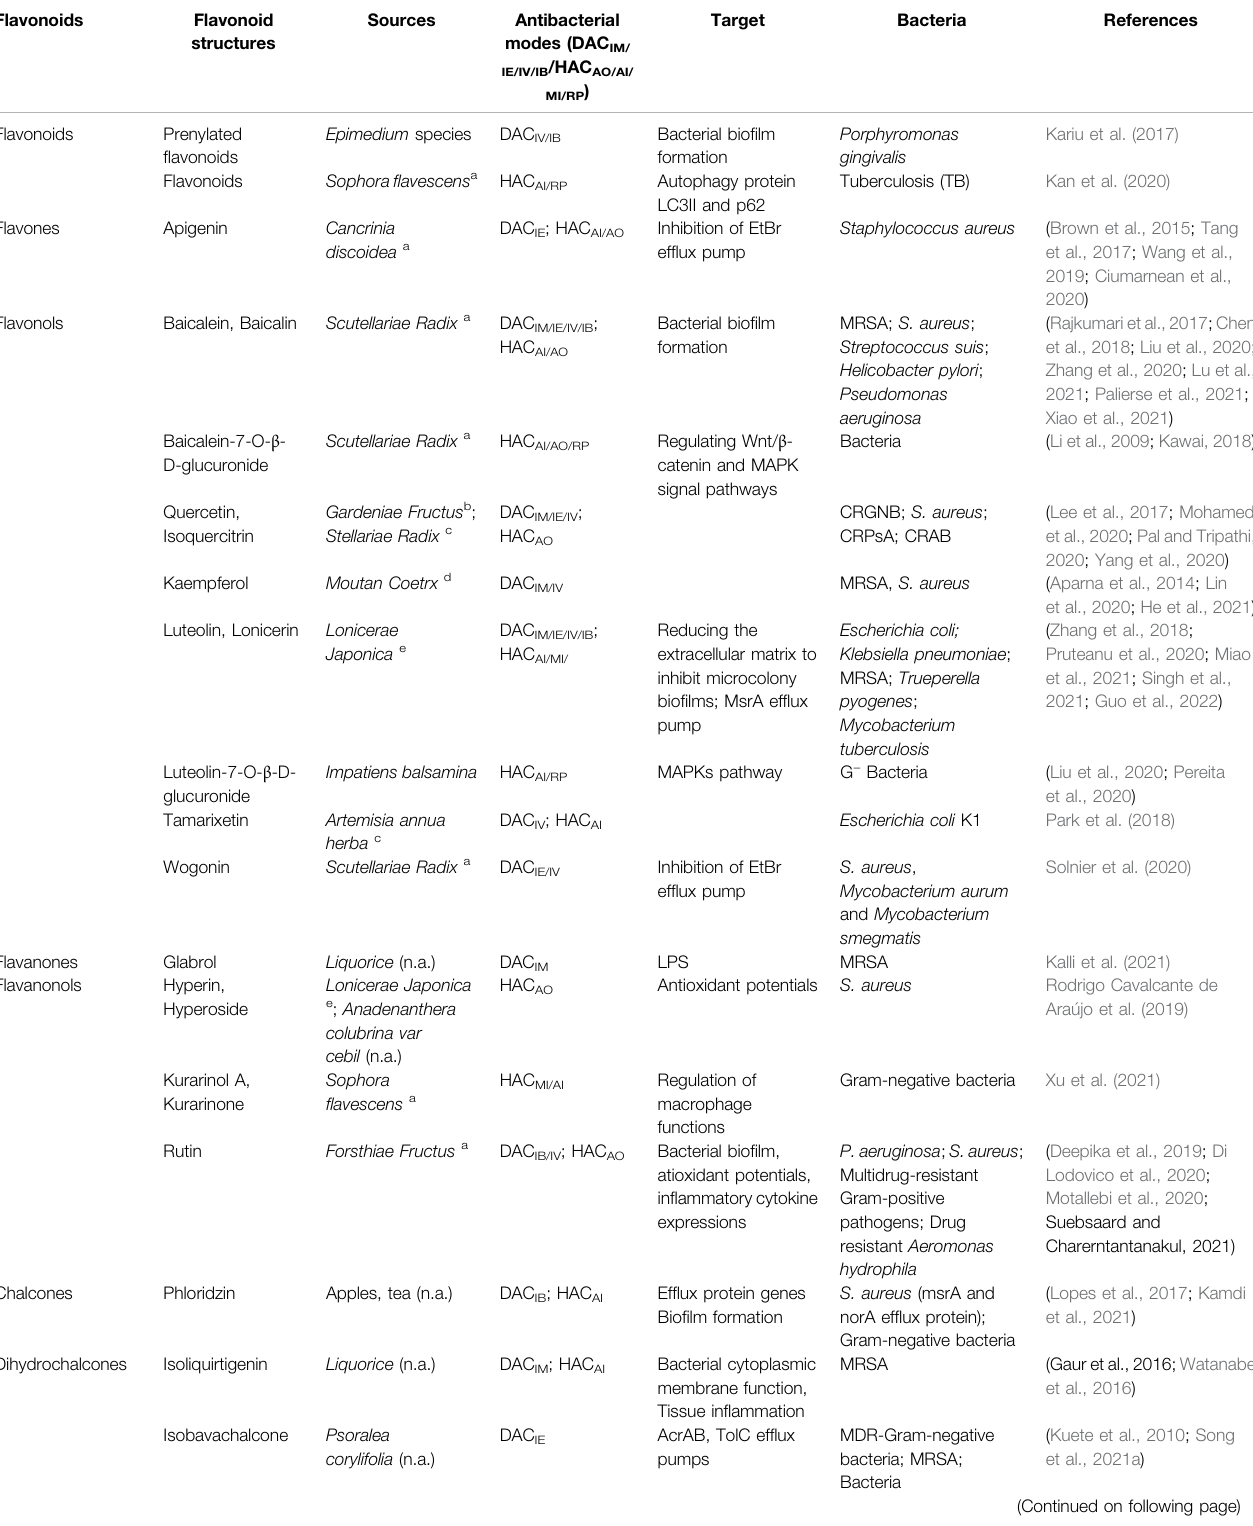
TABLE 1 | Antibacterial modes of natural plant fl avonoids and the main target